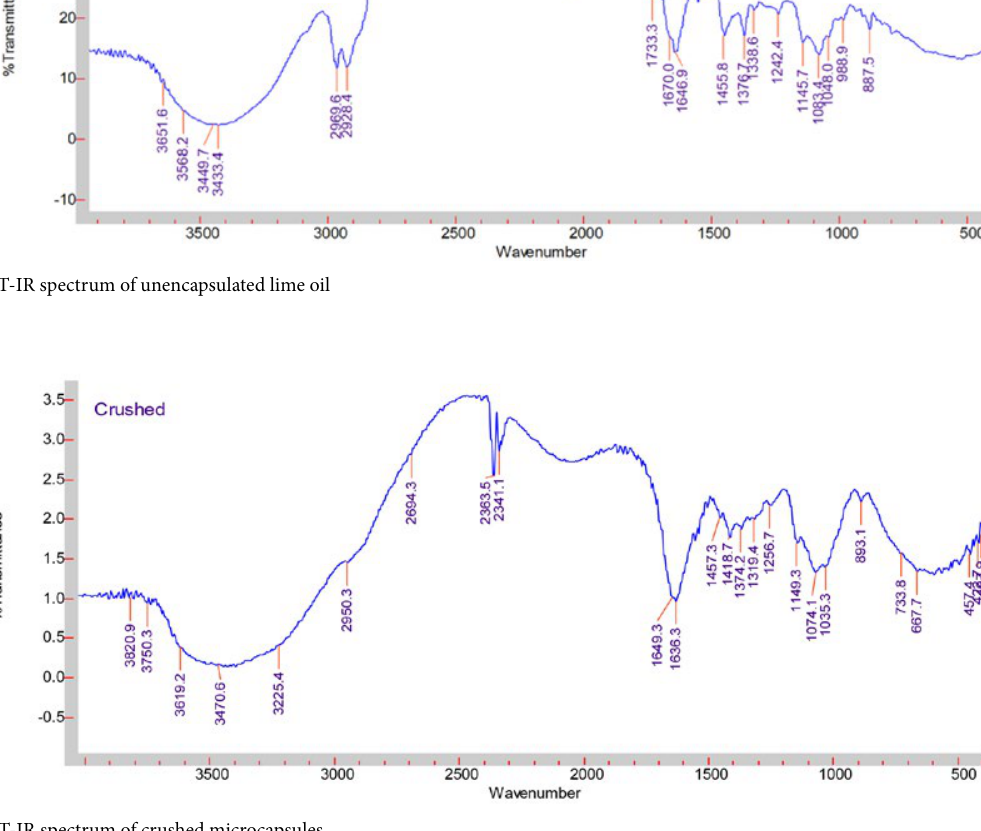
Figure 2. FT-IR spectrum of crushed